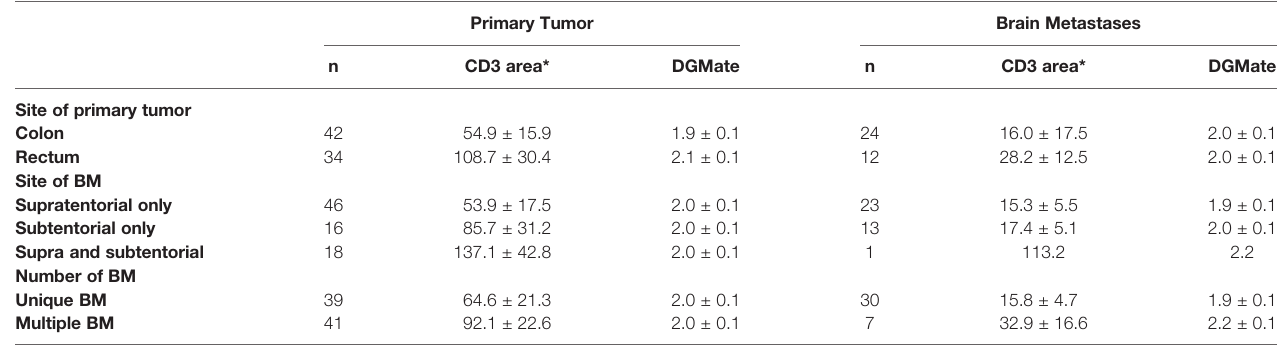
TABLE 3 | CD3 T-cell in fi ltration and DGMate score in primary tumor and brain metastases according to BM site and BM numbers.